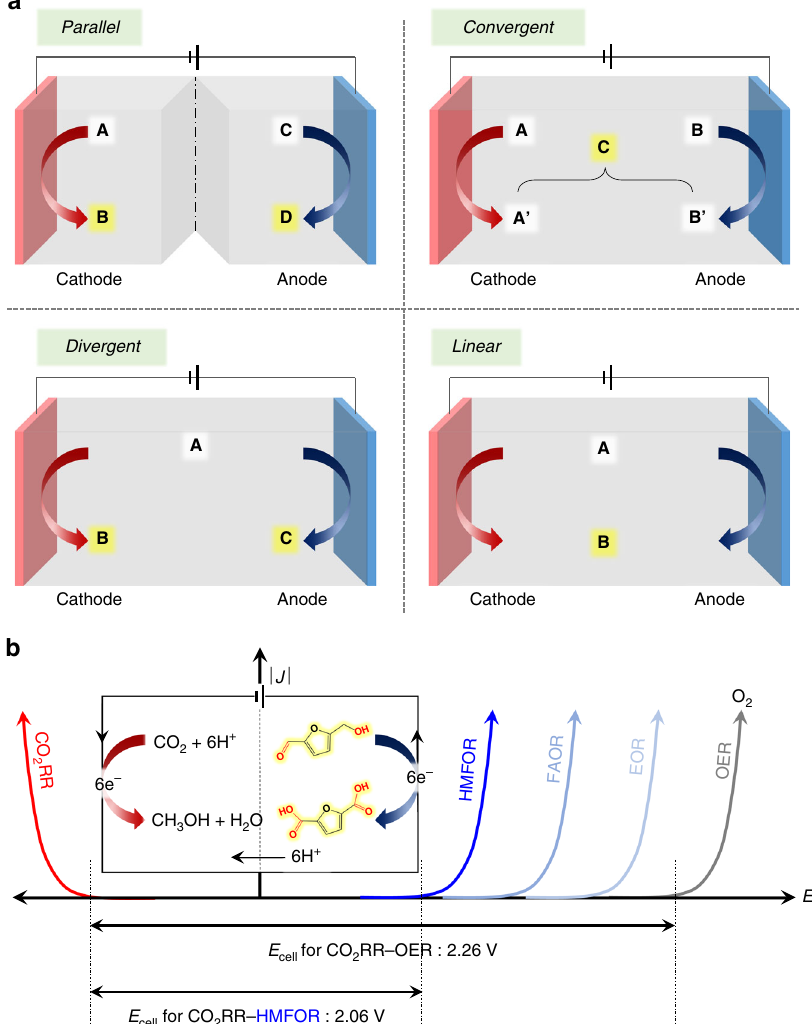
Fig. 1 Schematic illustration of the electrochemical coproduction system. a Parallel, convergent, divergent, and linear paired electrolysis. b I – V curves and required potentials at the cathode and anode for